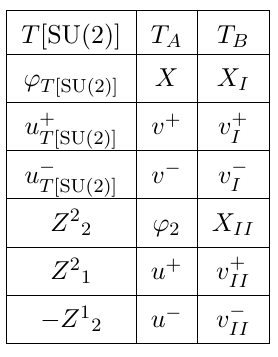
Table 5 . Mirror map of operators for the T [SU(2)] (in the notation of [9]), T A and T B theories. Each theory is also self-dual under a mirror symmetry exchanging the two branches of vacua ((cid:12)rst three rows exchanged with last three rows).